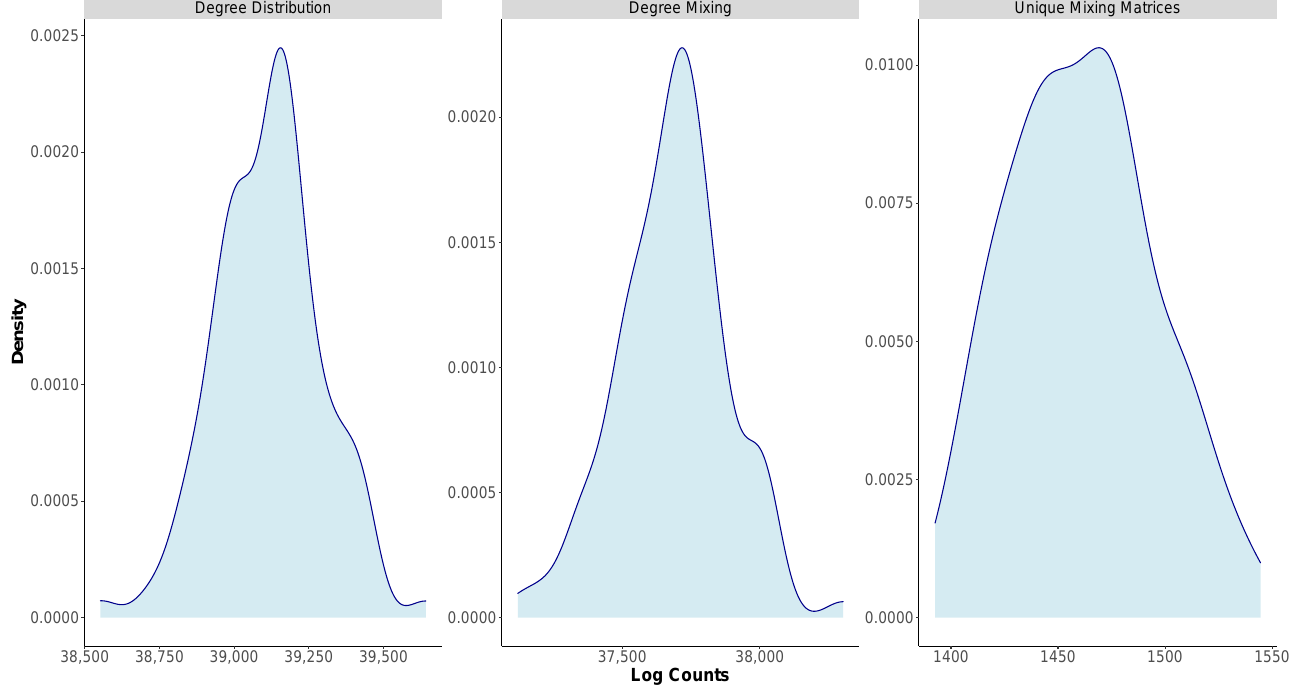
Figure 2. Barabási–Albert (BA) model: Density plots for the log estimates for | c φ panel) [degree distribution], | c φ degree mixing matrices associated with a degree distribution generated from the BA